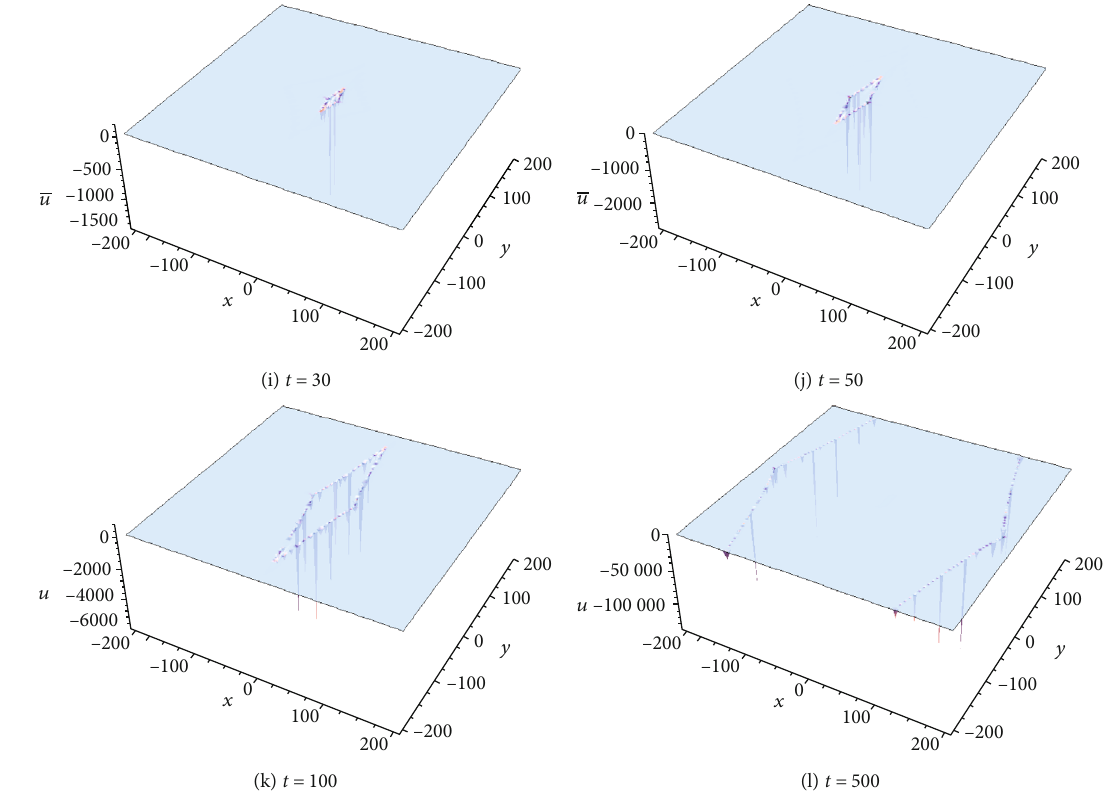
Figure 15: Falling and spreading phenomena of a columnar structure in the fractional two-soliton solution u with α = 82/99 .